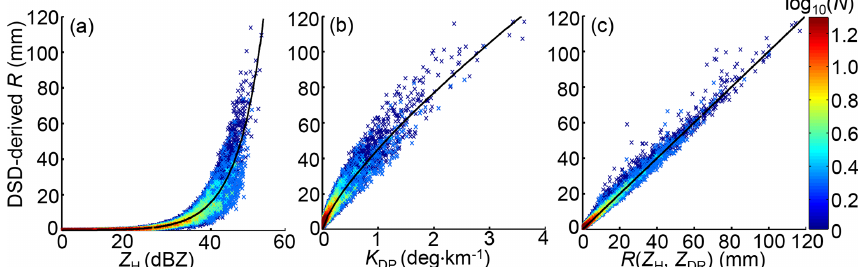
Figure 20. The scattergram of (a) DSD-derived R vs. Z H , (b) DSD-derived R vs. K DP , and (c) DSD-derived R vs. R estimated by fitted R ( Z H , Z DR ).